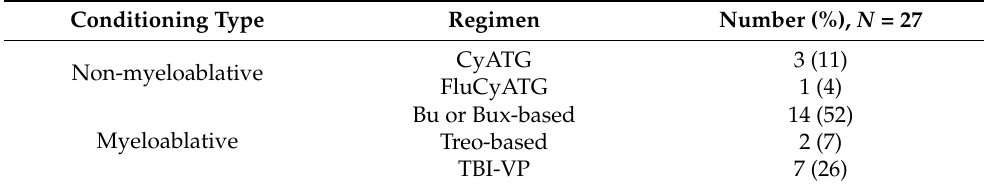
Table 2. Conditioning regimens.